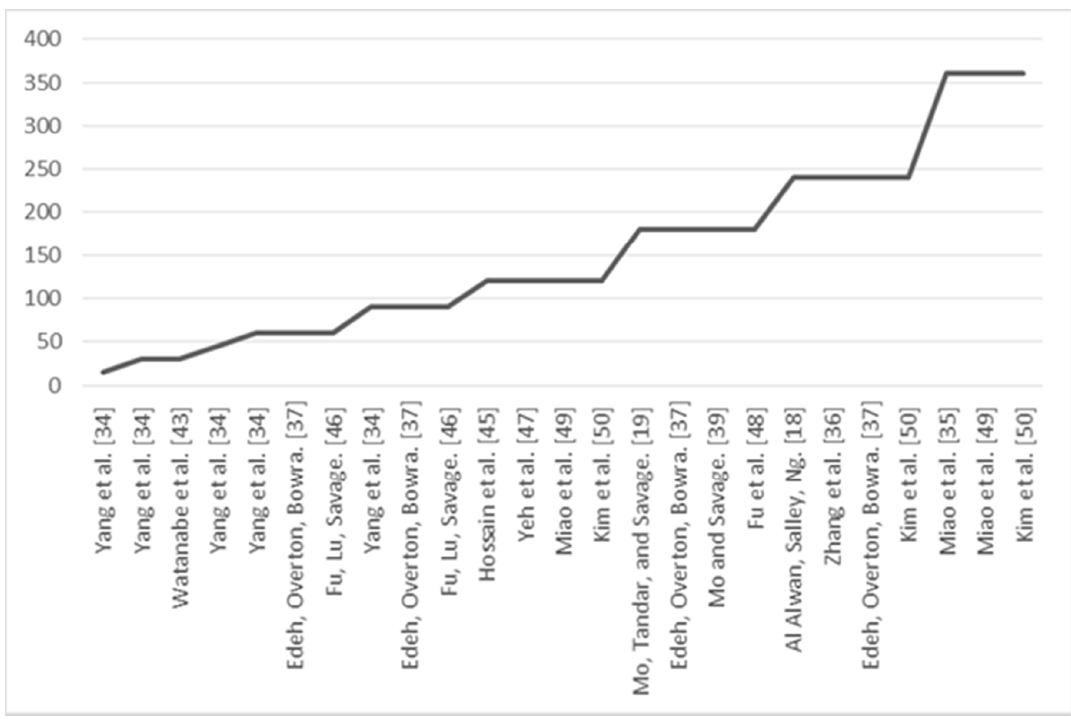
Figure 10. Residence time (minutes) in hydrothermal experiments with fatty acids.